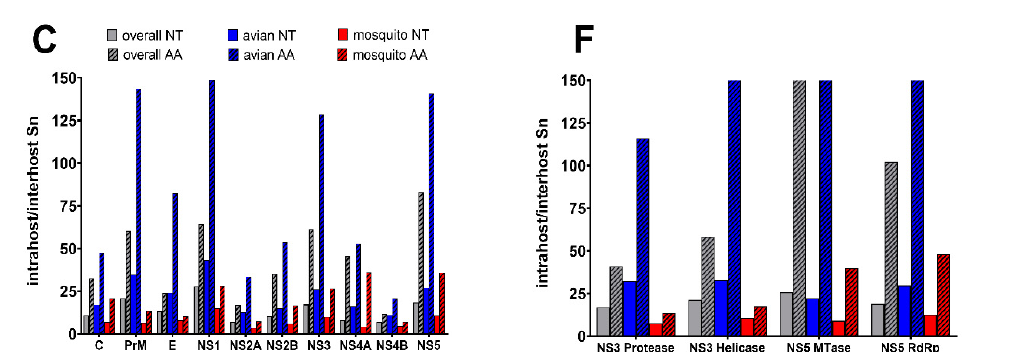
Figure 3. Gene-specific and host-specific differences for West Nile virus (WNV) inter and intrahost genetic diversity. Mean entropy (Sn) per gene for inter and intrahost nucleotides (NT) ( A ), and amino acids (AA) ( B ), is shown in the context of subunits of the NS3 and NS5 genes for NT ( D ) and AA ( E ). Interhost Sn was compared between avian and mosquito hosts for each gene and subunit using a Welch’s T-test where ** p < 0.005 and * p < 0.05. Intrahost S n was also compared; however, all relationships were significant ( p < 0.0001). The ratio of intra to interhost NT data for each gene ( C ) and each subunit within NS3 and NS5 ( F ).